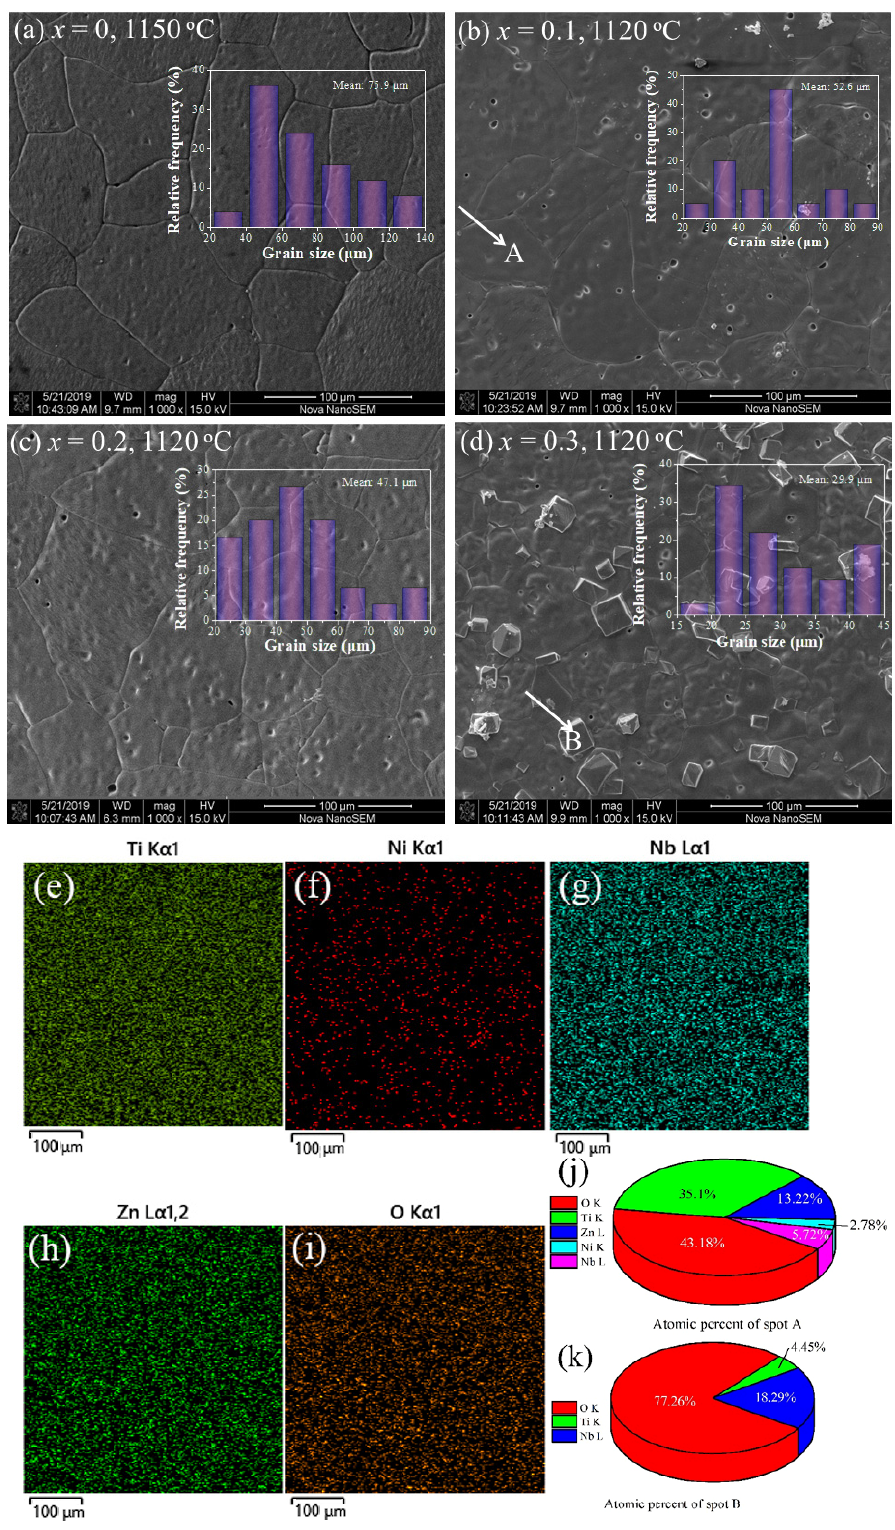
Fig. 4 SEM images of LZTNN x ceramics with various x values sintered at the optimized temperatures: (a) x = 0 at 1150 , ℃ (b) x = 0.1 at 1120 , (c) ℃ x = 0.2 at 1120 , and (d) ℃ x = 0.3 at 1120 . The insets display grain size distribution and mean grain ℃ size of each sample. (e–i) elemental distribution mappings of LZTNN0.2 ceramics sintered at 1120 , (j) EDS elemental point ℃ scanning results of spot A, and (k) EDS elemental point scanning results of spot